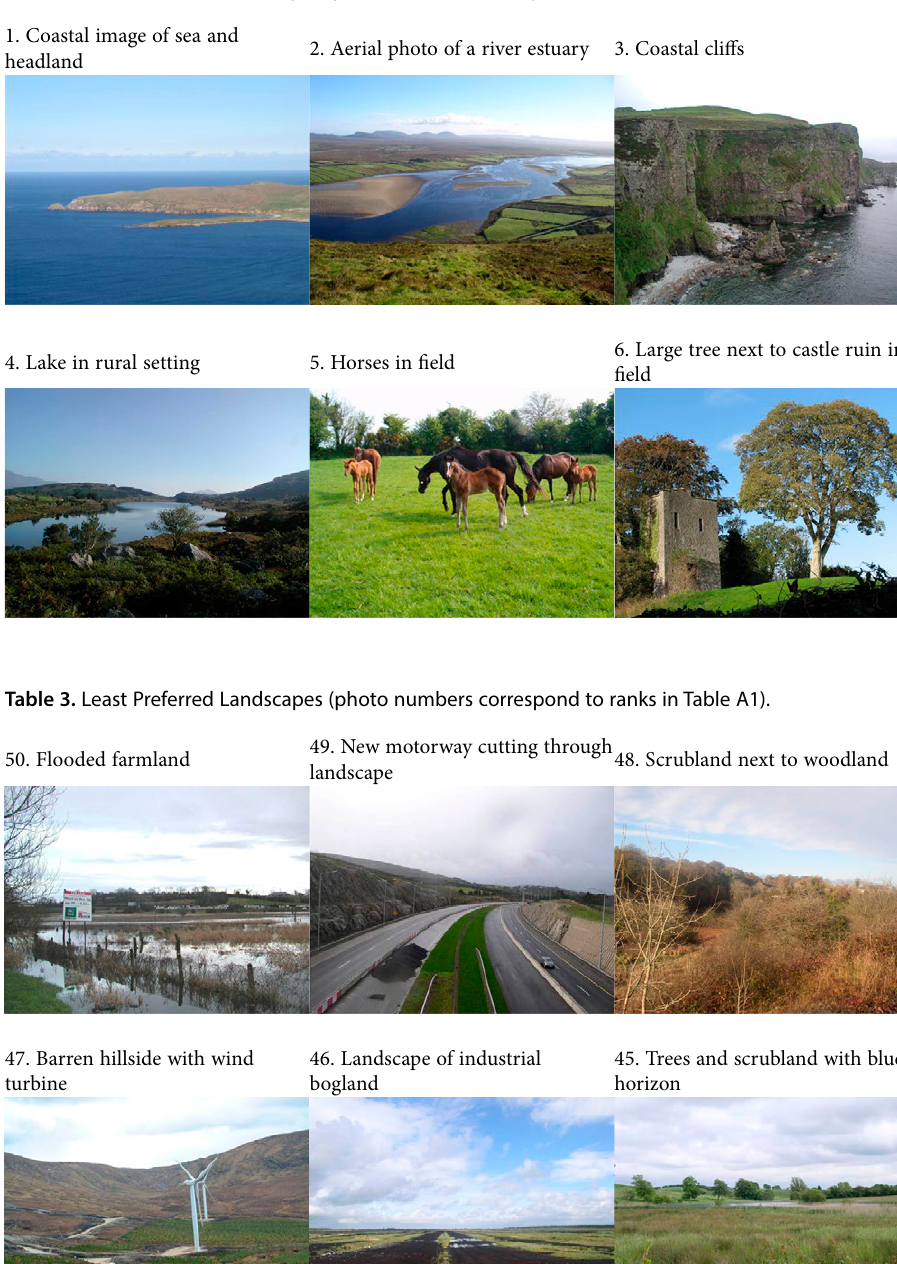
Table 2. Most Preferred Landscapes (photo numbers correspond to ranks in Table A1-Data Annex).